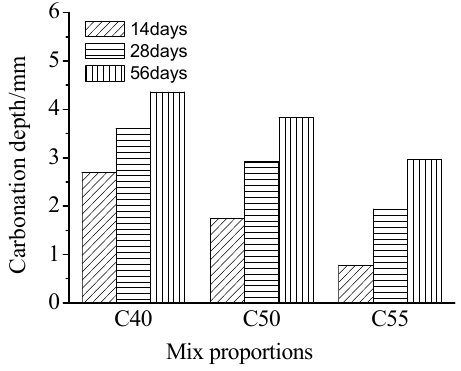
Figure 7. Carbonation depth of C40, C50, and C55 at different exposure times.